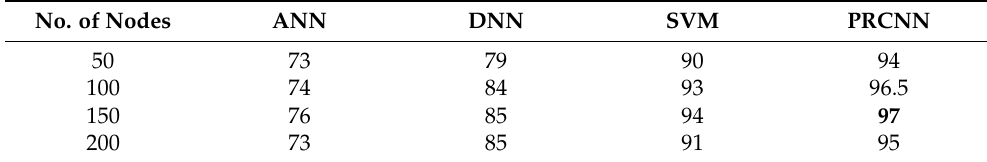
Table 5. Sensitivity comparison analysis between proposed and existing